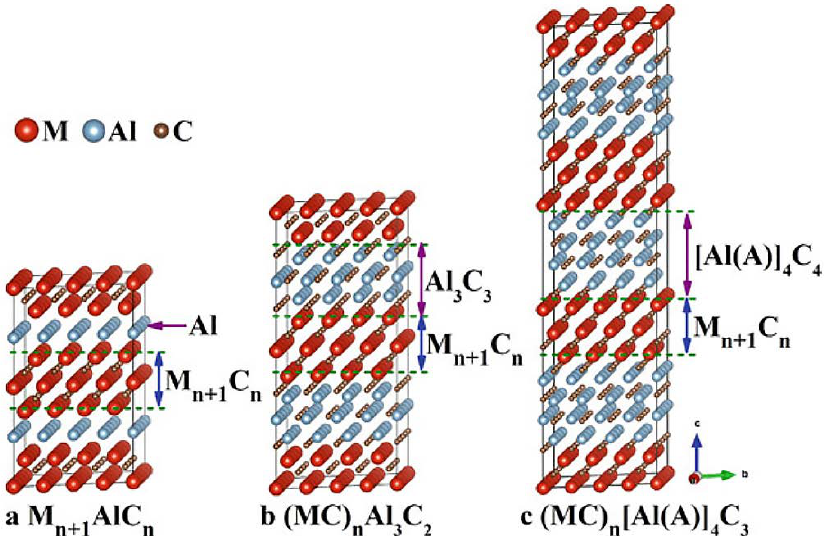
Figure 6. A comparison of the structure of the MAX-phase (M n+1 AlC n ) ( a ) and layered ternary ( b ) and quaternary ( c ) carbides of the type (MC) n [Al(A)] m C m-1 (n = 1, 2, 3, m = 3 and 4). Reprinted with permission from [49] 2019 Springer Nature.